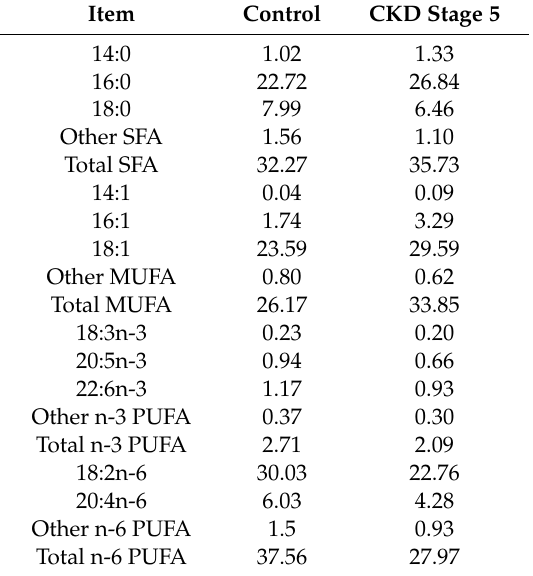
Table 3. Content of fatty acids in extracts from patients with chronic kidney disease (CKD) stage 5 and healthy controls serum mixes used for hepatocyte treatment in vitro. The data are presented as a fatty acid proportion (%). SFA—saturated fatty acids, MUFA—monounsaturated fatty acids, PUFA—polyunsaturated fatty acids.